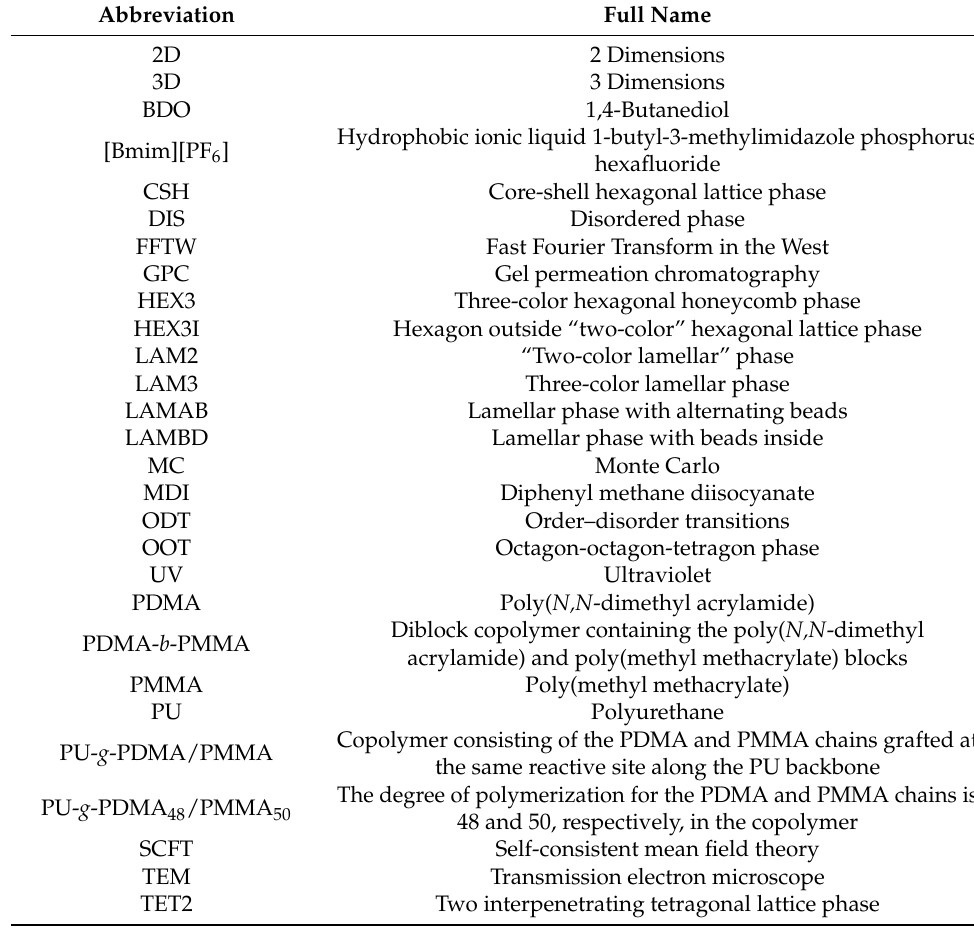
Table A1. The abbreviations used in this paper and their full names.